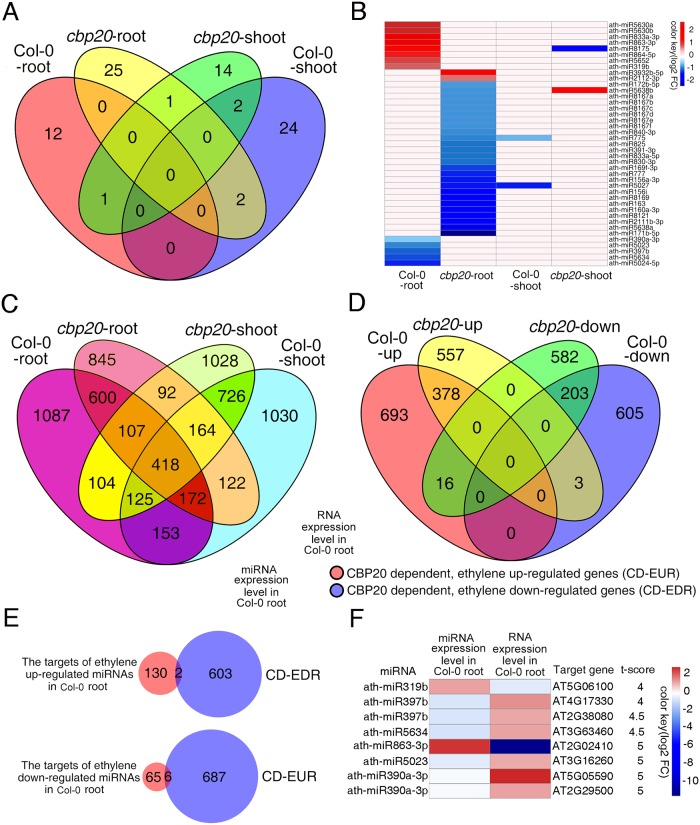
Small RNA and RNA sequencing analysis of CBP20 regulated miRNAs and RNAs in roots and shoots with ethylene treatment.(A) The Venn diagram shows the numbers of ethylene regulated miRNAs in the roots or shoots of Col-0 and cbp20 mutant. The miRNAs, which are differentially regulated by ethylene in the shoots or roots of Col-0 or cbp20 are compared. (B) Heat map shows the expression level of differential regulated miRNAs in the root and shoot of Col-0 and cbp20 mutant with ethylene treatment. Total small RNA was prepared from the roots or shoots of 3-day-old etiolated seedlings of Col-0 or cbp20 plants treated with air or 4 h ethylene. Differentially expressed miRNA requiring a 1.5 fold change comparing the indicated conditions with P<0.05 after Benjamini–Hochberg correction. (C) The Venn diagram shows the numbers of ethylene regulated genes in the roots and shoots of Col-0 and cbp20 mutant. Total RNA was prepared from the roots or shoots of 3-day-old etiolated seedlings of Col-0 or cbp20 plants treated with air or 4 h ethylene. Differentially expressed genes were identified by fragments per kilobase per million reads (FPKM) filter<0.1, requiring a twofold change comparing the indicated conditions with P<0.05 after Benjamini–Hochberg correction (D) The Venn diagram shows the number of The CBP20 dependent differential regulated genes in Col-0 root after ethylene treatment. (E) The venn diagram shows the number of the targets of differential regulated miRNAs and the CBP20 dependent differential regulated genes in Col-0 roots after ethylene treatment. (F) Heat map shows the expression level of differential regulated miRNAs and their target genes in col root after ethylene treatment.